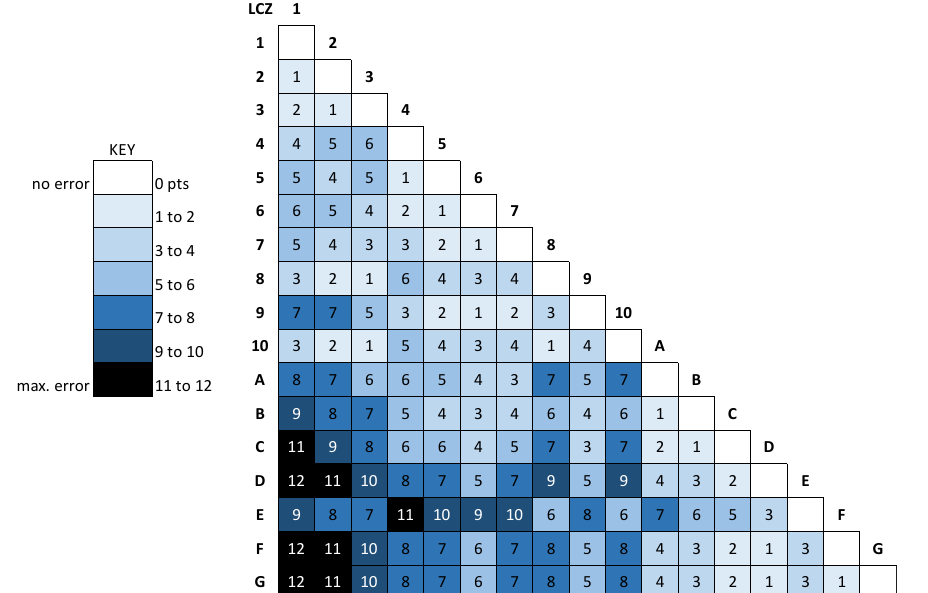
Figure 2. Dissimilarity of LCZ classes according to a 12-point diagnostic scheme by Stewart [6,8]. The scheme is based on surface properties of the LCZ classification, including openness, height, cover, and surface objects. Note that the methodology is under development and the original scores from [4] are presented. The similarity matrix has been improved and newer versions contain slightly updated scores.